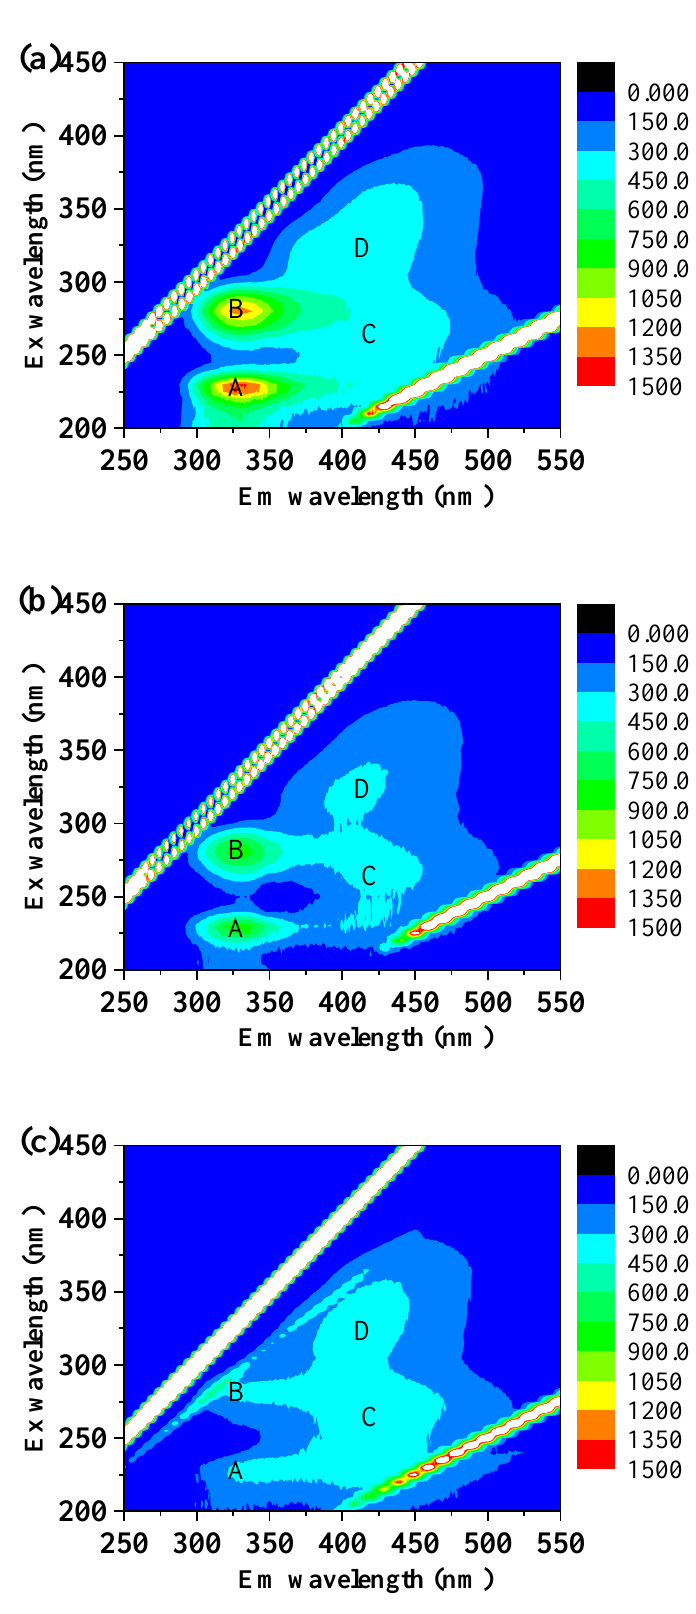
Figure 3. The removal performance of fluorescent substances by BAC-UF system: ( a ) raw water, ( b ) effluent of BAC, ( c ) BAC-UF permeate.